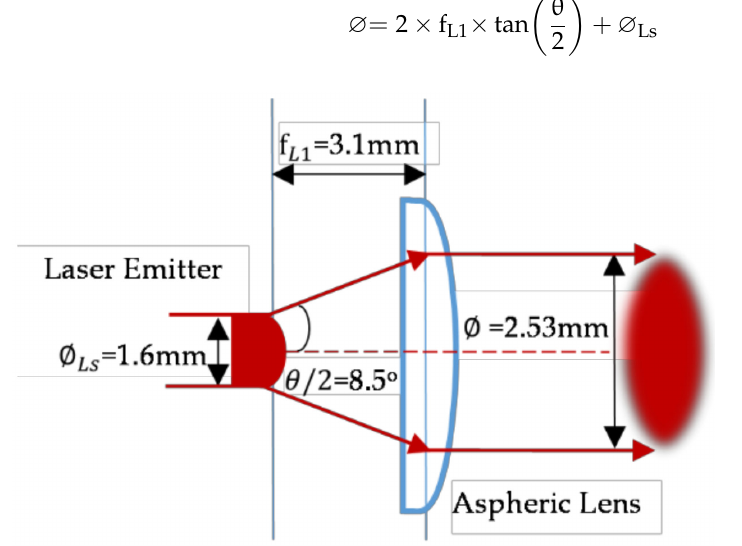
Figure 2. The collimating laser beam